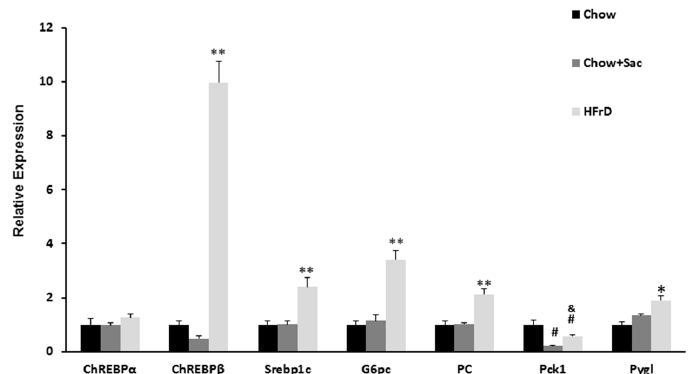
Figure 2. Fructose, not saccharin, increased the expression of genes in the liver which regulates CH metabolism, liver DNL, gluconeogenesis, and glycogenolysis. ChREBP α -carbohydrate-responsive element-binding protein α , ChREBP β -carbohydrate-responsive element-binding protein β , Srebp1c- subunit, PC-pyruvate carboxylase, Pck1-phosphoenolpyruvate carboxykinase 1, Pygl-glycogen phosphorylase. # p < 0.05 vs. chow; * p < 0.05 vs. chow and chow + Sac; ** p < 0.01 vs. chow and chow + Sac; & p < 0.05 vs. Sac.